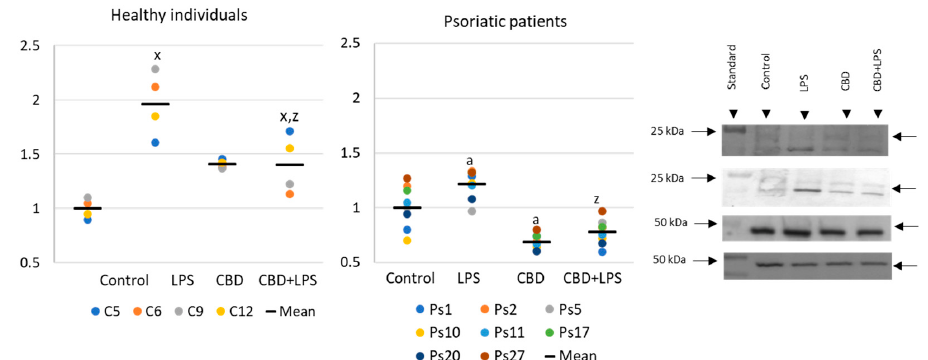
Figure 4. Citrullinated H3-histone expression in human neutrophils from heathy subjects ( n = 4) and psoriatic patients ( n = 8) after 1 h incubation with LPS, cannabidiol and LPS with cannabidiol. a—statistically significant difference between neutrophils from patients with psoriasis vulgaris and healthy subjects p < 0.05; x—statistically significant difference between treated neutrophils (with LPS, CBD, or LPS + CBD) and non-treated (control) cells; p < 0.05; z—statistically significant difference between neutrophils treated with LPS + CBD and treated only with LPS; p < 0.05.